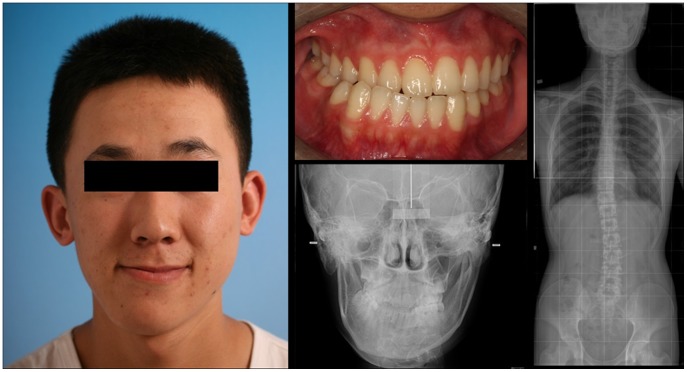
Image from a typical patient with mandibular deviation.Anterior X-ray film. The lengths of the mandibular rami have an obvious difference. The vertical distance from the chin ridge to the inferior orbital fissure line is greater than 2 mm.